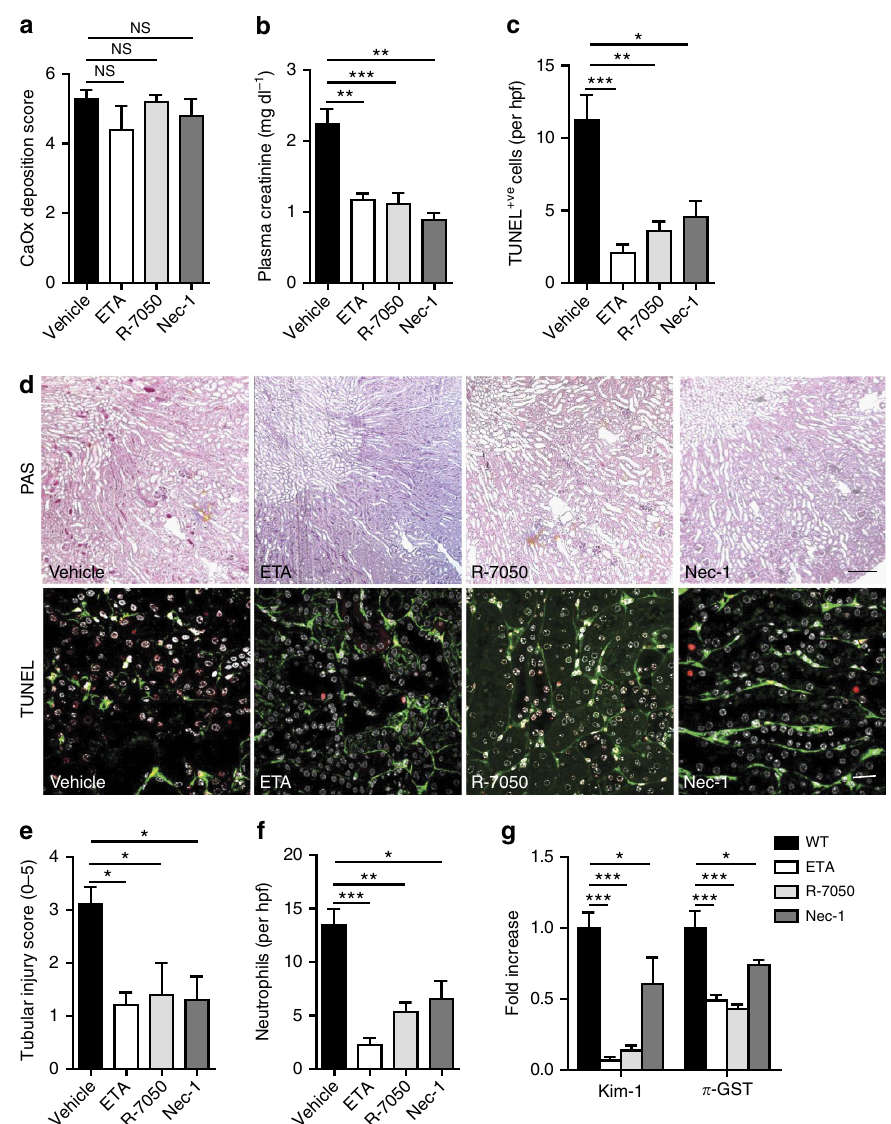
Figure 8 | Etanercept, R-7050, and necrostatin-1 abrogate crystal nephropathy. ( a – c ): Oxalate injection to wild-type mice treated either with vehicle, the TNF- a blocker etanercept, the TNFR blocker R-7050 or necrostatin (Nec)-1 ( n ¼ 5 in each group) resulted in identical amounts of CaOx